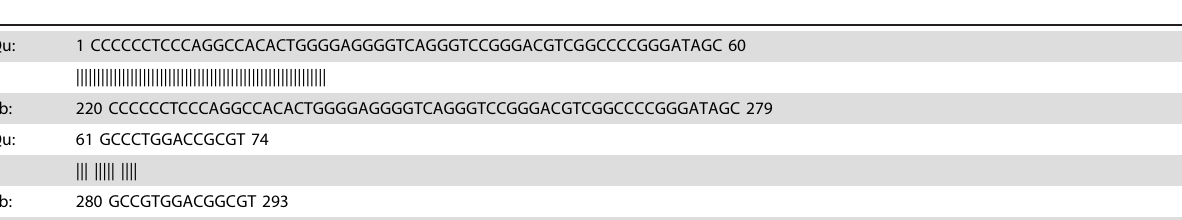
Table 1. Sequence Data of the T. cruzi amplification